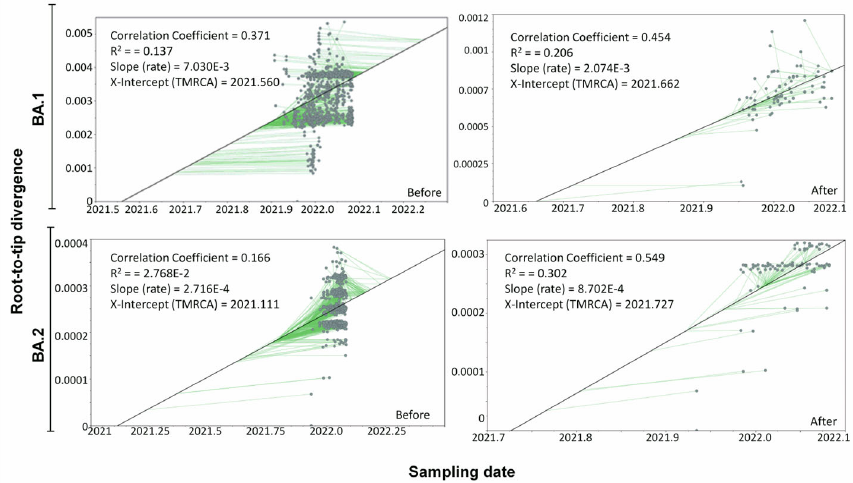
Figure 3. Root ‐ to ‐ tip regression analyses on the maximum likelihood (ML) trees generated for orig ‐ inal dataset comprising Omicron BA.1 and BA.2 sub ‐ lineages (Before) and dataset after removing dataset comprising Omicron BA.1 and BA.2 sub-lineages (Before) and dataset after removing the the outliers (After). outliers